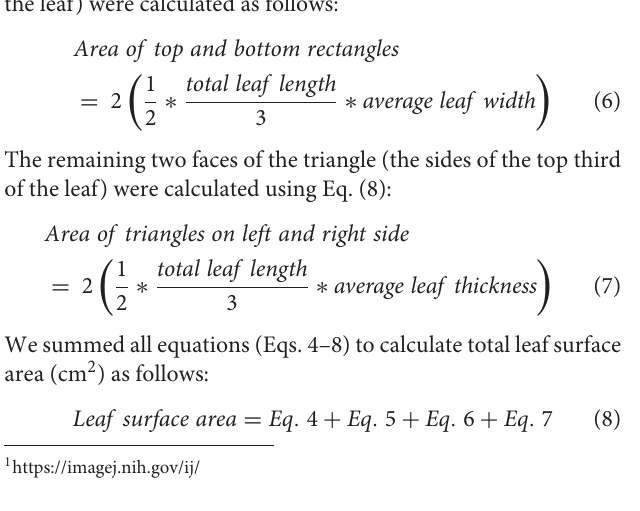
Frontiers in Plant Science |